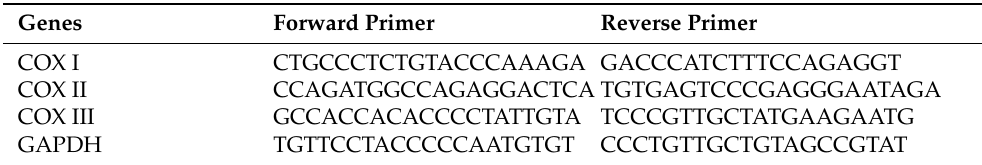
Table 4. Sequences of primers for quantitative real-time